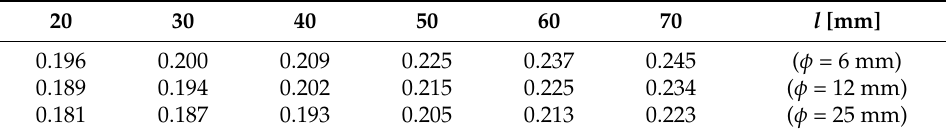
Table 1. Values of resonance points l / λ res of cylindrical